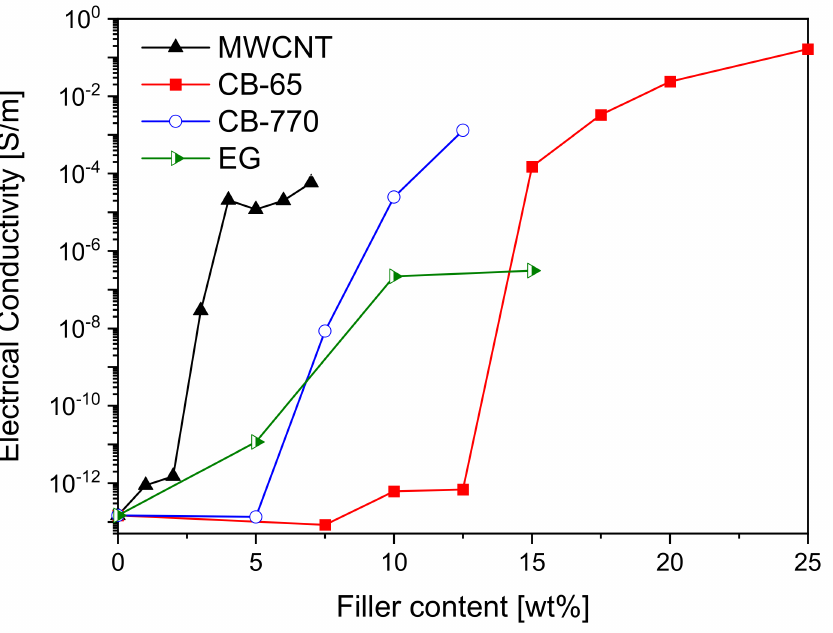
Figure 2. DC electrical conductivity of carbon-based nanocomposites at different additives